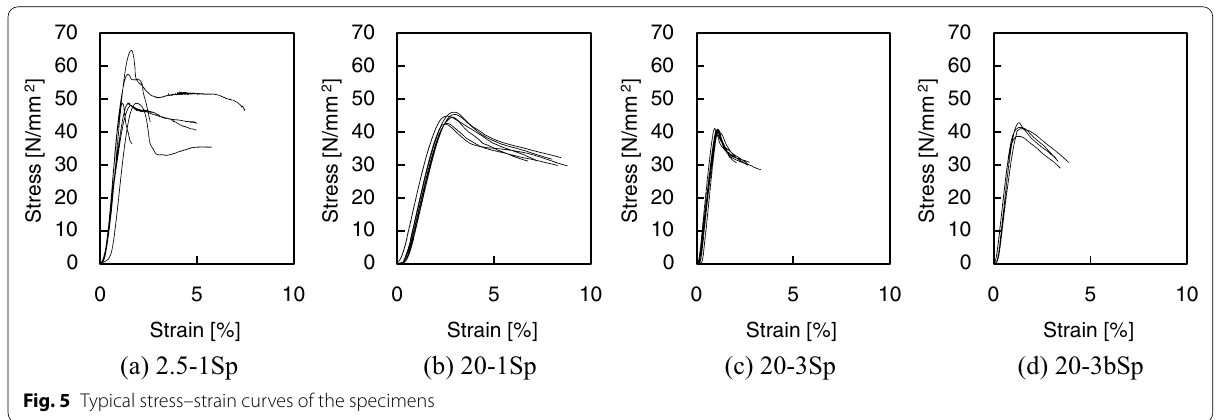
Fig. 5 Typical stress–strain curves of the specimens